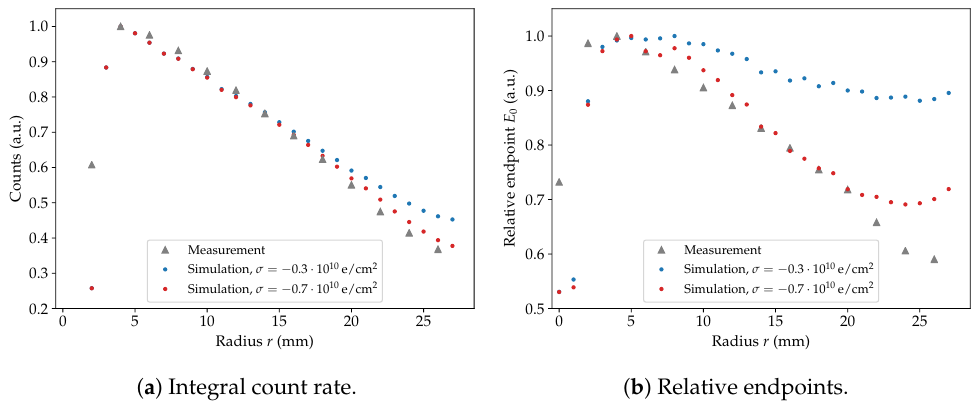
Figure 21. Comparison of measurement to simulation: ( a ) Integral count rate and ( b ) relative endpoints of the 90 Sr E obs energy spectra. Simulation results are shown for the surface charges β σ = 0.3, 0.7 10 10 e/cm 2 − − ×